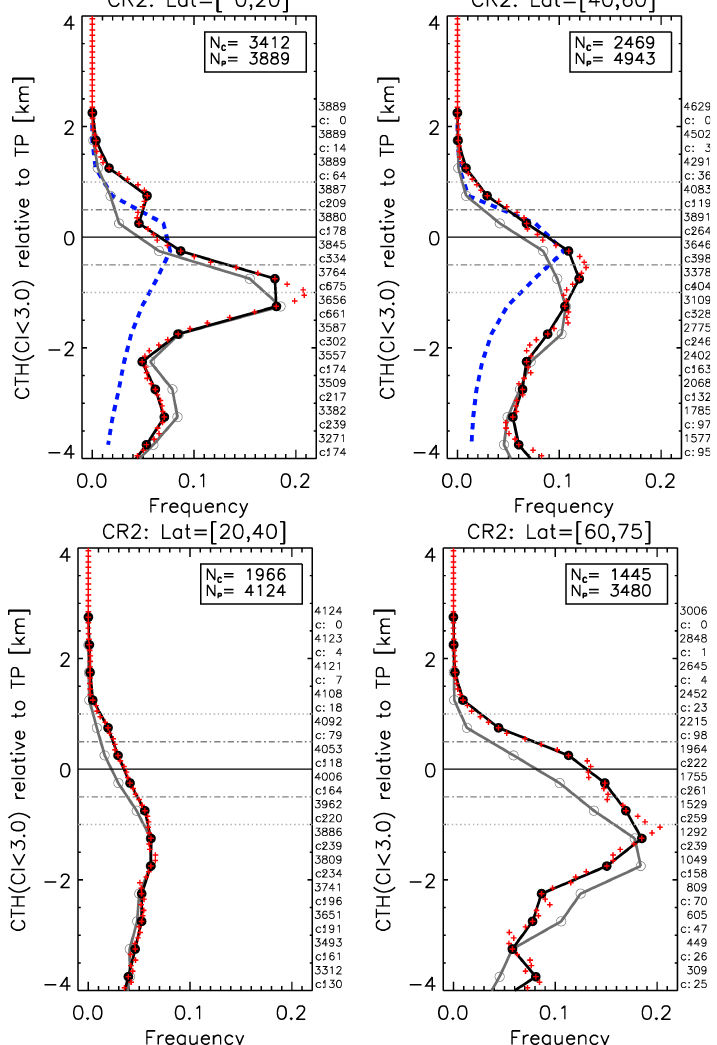
Figure 4. Cloud occurrence frequencies of CTHs relative to the tropopause for four latitude bands and the two detection thresholds CI thres = 2 (grey circles) and CI thres = 3 (black dots). The numbers on the right y axis highlight the number of observations (top number) and the number of CTH counts (c:) in the corresponding altitude grid box (500m) for CI thres = 3. The blue dashed line in the top two figures represents the JJA mean COF values for CALIPSO from June 2006 to May 2010 (taken from Fig. 10 in PM2011). Uncertainty limits of ± 0.5 and 1km are presented by the horizontal lines. Red symbols represent a 100m running mean statistic of 500m vertical